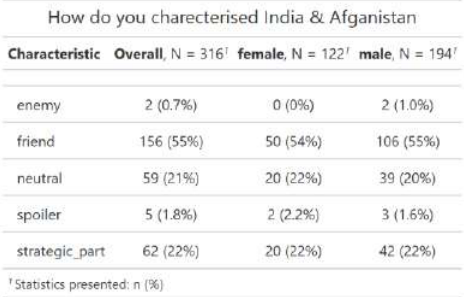
India is the largest democracy globally, with a huge Muslim population. For multi-ethnic Afghanistan, 72 percent of respondents (29% very strongly and 43% strongly) agree that